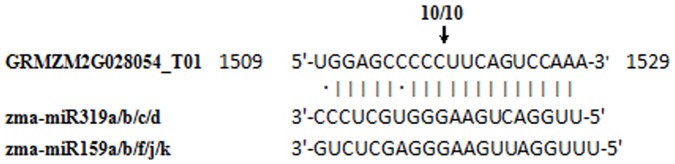
Zma-miR319/miR159 cleavage site in GRMZM2G028054_T01 mRNAs determined by 5'-RLM-RACE.The vertical lines represent the nucleotides that base-pair with GRMZM2G028054_T01 and dots show the mismatched nucleotide. Arrow indicates the 5'termini of mRNA fragments and the frequency of 5'-RACE clones corresponding to cleavage side.